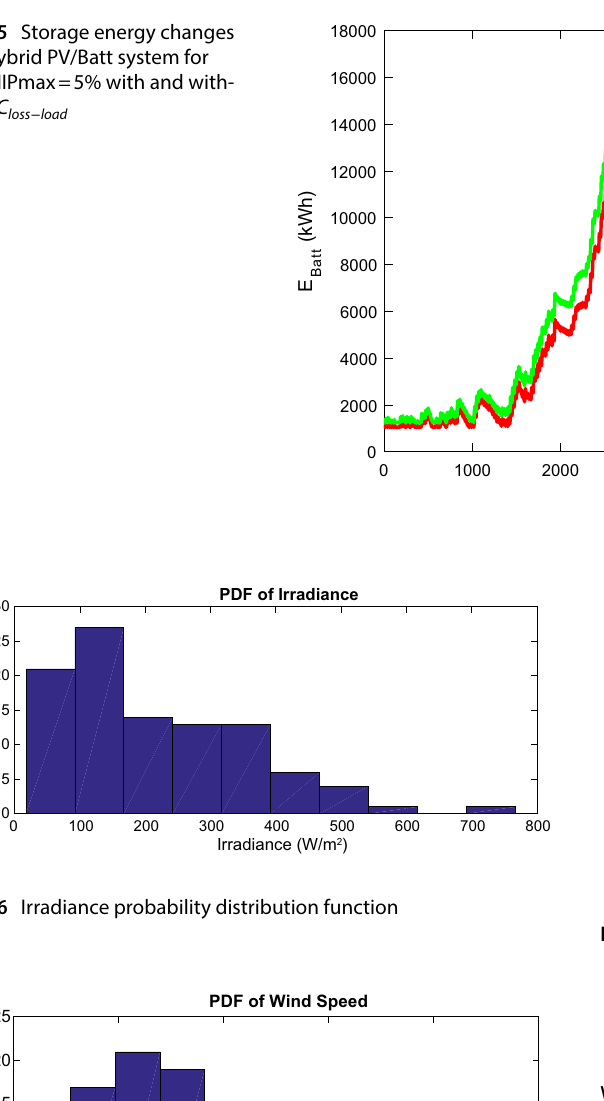
Fig. 5 Storage energy changes of hybrid PV/Batt system for DPHIPmax = 5% with and with- out C loss − load